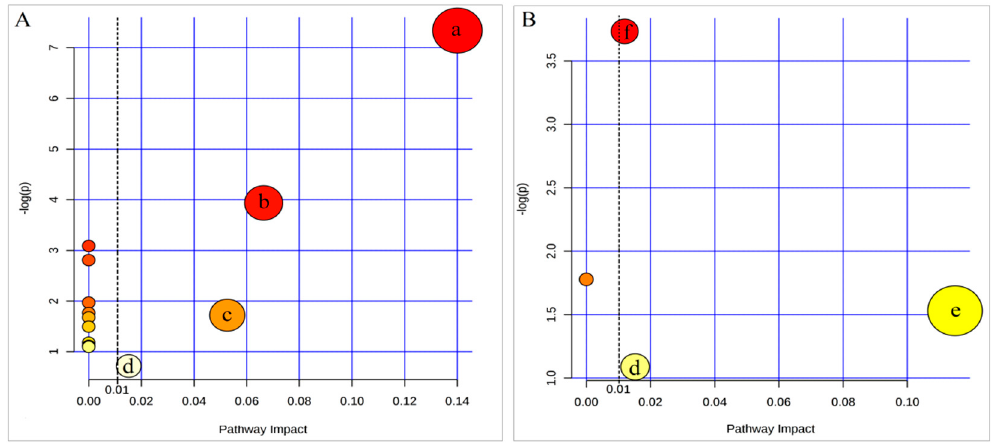
Figure 8. Detection of the metabolic pathway topology analysis. ( A ) CFS group vs. NC group. ( B ) Se-TP group vs. CFS group. (a: citrate cycle; b: alanine–aspartate–glutamate metabolism; c: sphingolipid metabolism; d: steroid hormone biosynthesis; e: tyrosine metabolism; f: arginine-proline metabolism).